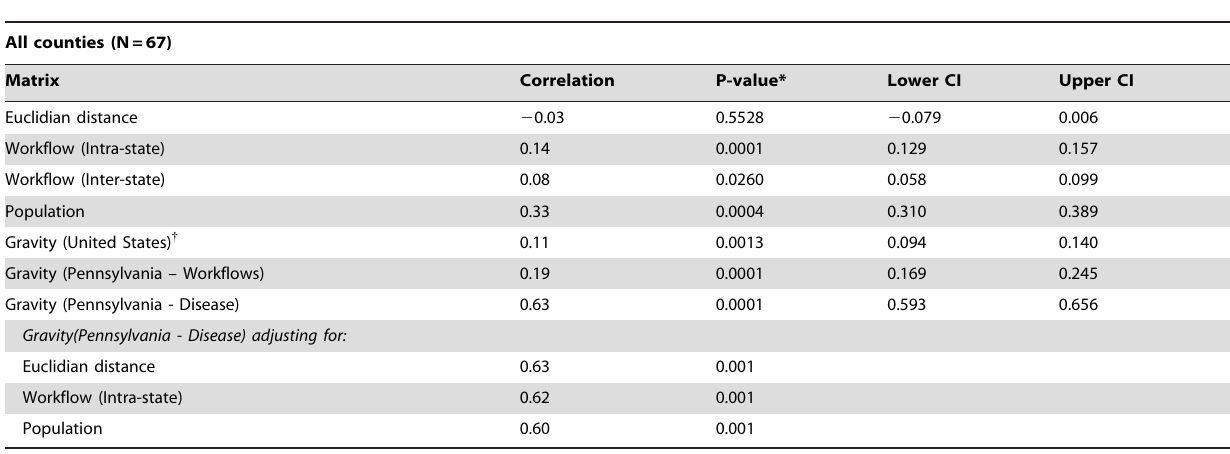
Table 2. Observed Mantel